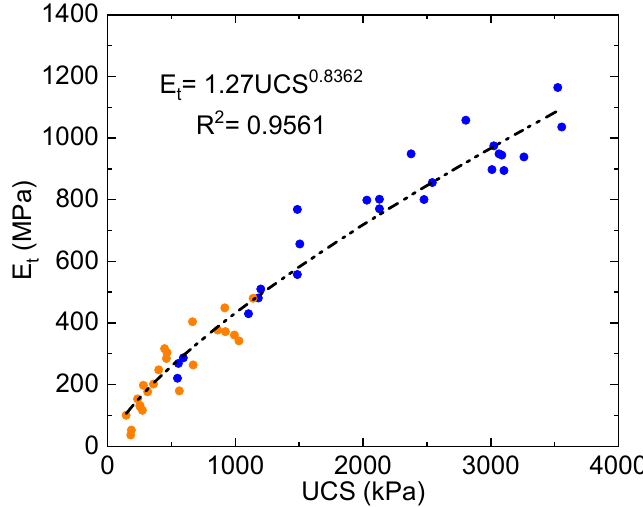
Figure 7. Relationship between E t and UCS at 28-day cure time for Garpenberg with Portland (orange markers) and Portland/slag blended (blue markers) binders (data from [19]).